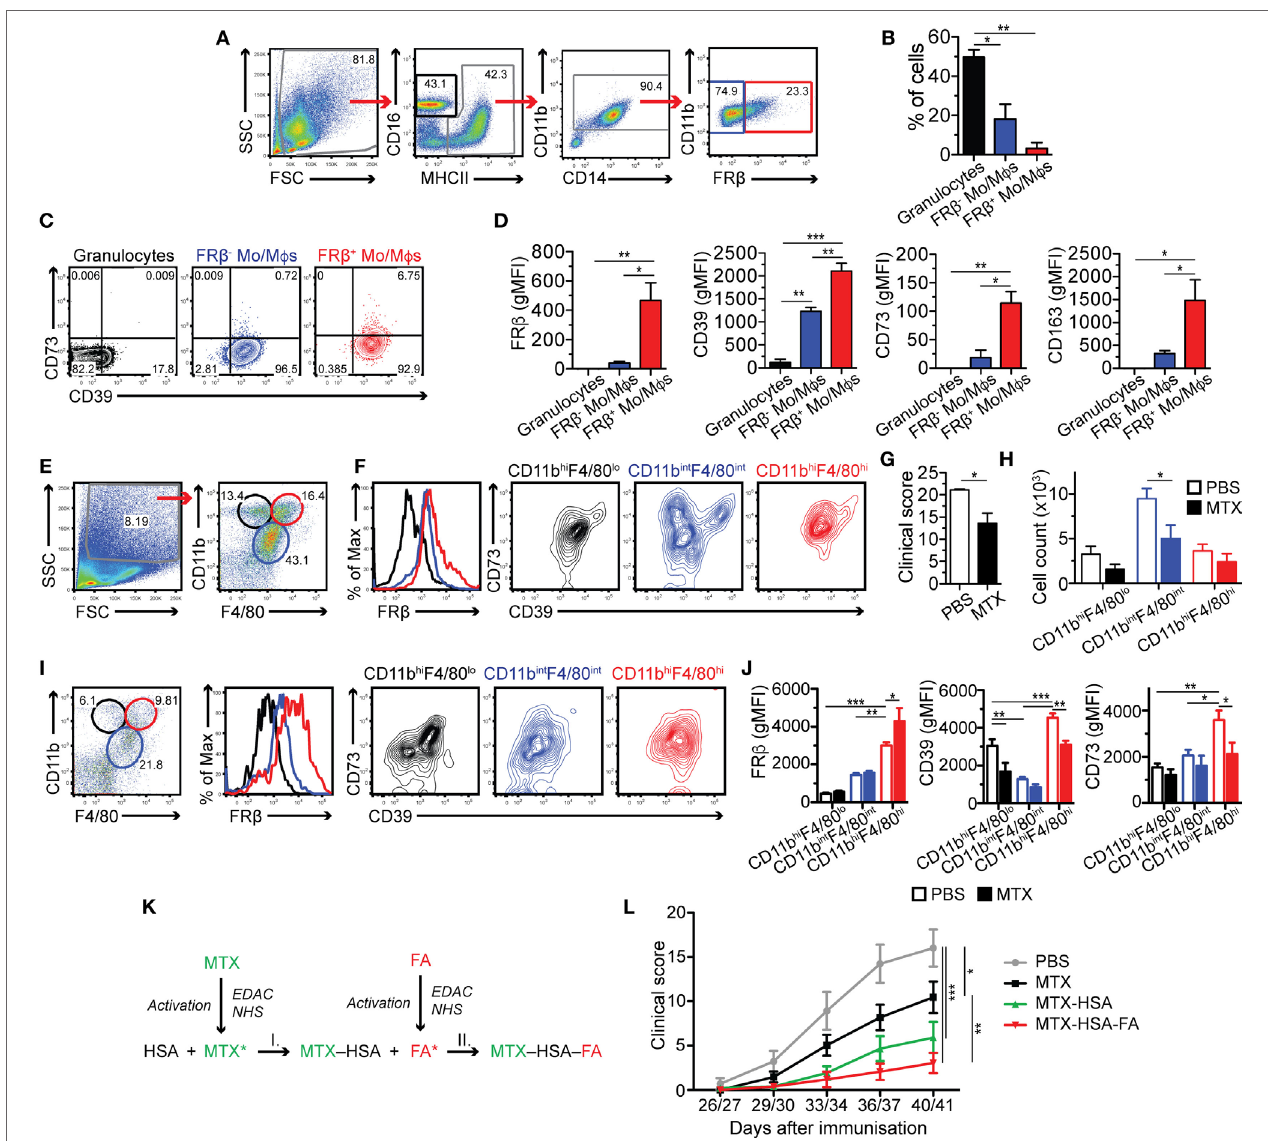
FigUre 7 | FR β hi CD39 + CD73 + macrophages (M ϕ s) are present in arthritic joints of man and mouse and their targeting with methotrexate (MTX) suppresses joint inflammation. (a) Gating strategy to identify innate immune cell populations in the knee synovial fluid from arthritis-affected patients analyzed by flow cytometry. Granulocytes were identified as CD16 hi MHCII − /lo (black gate). MHCII + CD11b + CD14 + M-CSF-dependent monocytes/macrophages (Mo/M ϕ s) were discriminated by prominent folate receptor β (FR β ) staining (red gate), while GM-CSF-dependent Mo/M ϕ s were identified as FR β − (blue gate). (B) Frequency of CD16 hi MHCII − /lo granulocytes, FR β − and FR β + Mo/M ϕ s in the synovial fluid of arthritis-affected patients. Data represent mean ± SEM of three patients. (c) CD39 and CD73 co-expression on granulocytes, FR β − and FR β + Mo/M ϕ s present in the synovial fluid of arthritis-affected patients. One representative staining of three patients is shown. (D) FR β , CD39, CD73, and CD163 surface expression [measured as the geometric mean of fluorescence intensity (gMFI)] in the three populations was statistically evaluated. Data represent mean ± SEM of three experiments. (e) Cells, isolated from ankles of arthritic DBA/1JRj mice, were analyzed by flow cytometry using the forward and side-scatter characteristics and CD11b and F4/80 expression. Three distinct populations were identified: CD11b hi F4/80 lo cells (black gate), CD11b int F4/80 int M ϕ s (blue gate), and CD11b hi F4/80 hi M ϕ s (red gate). (F) The populations were analyzed for FR β (histogram on the left), CD39, and CD73 expression (contour plots on the right). (g) Clinical score of mice treated with PBS or MTX, respectively, on day 41. (h) Quantification of CD11b hi F4/80 lo , CD11b int F4/80 int , and CD11b hi F4/80 hi subsets isolated from ankles of PBS- or MTX-treated arthritic mice [representative dot plots shown in (e,i) ] within the forward and side-scatter gate [shown in (e) , left]. (i) CD11b hi F4/80 lo , CD11b int F4/80 int , and CD11b hi F4/80 hi populations from MTX-treated arthritic mice (dot plot on the left), and their FR β (histogram in the middle), CD39 and CD73 expression (contour plot on the right). One representative of two similar experiments of 3 + 3 mice; where each ankle was analyzed separately. (J) FR β , CD39, and CD73 surface expression (measured as gMFI) shown in (F,i) was statistically evaluated. Data represent mean ± SEM of 3 + 3 mice with two ankles analyzed separately. (K) Conjugation strategy using N -(3-dimethylaminopropyl)- N -ethylcarbodiimide hydrochloride (EDAC) and N -hydroxysuccinimide (NHS), to create MTX-human serum albumin (HSA) conjugates (conjugation I) and MTX-HSA-folic acid (FA) conjugates (step I + II). (l) Mean clinical score ( ± SEM) of mice treated with various MTX formulations. Data are pooled from two independent experiments with 7–12 mice/group. The treatment and scoring in the second experiment was done one day earlier than in the first one. Statistical significance was assessed by one-way ANOVA (B,D) , unpaired two-tailed t -test (g) and two-way ANOVA (h,J,l) . * p < 0.05, ** p < 0.01, *** p <